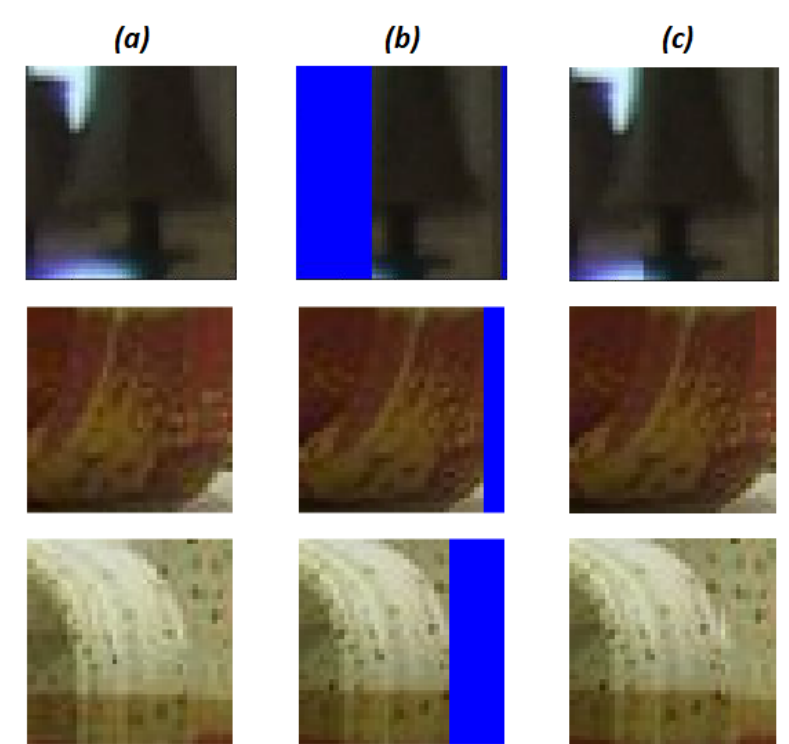
Figure 6. Examples of block composition performed to overcome with partial matching blocks. Each row shows an example of block composition, the first row shows the block number 111 ( a ) of the image “Flowers 1”, the partial matching block ( b ) and the composed block ( c ). The second and third rows are examples of partial matching of blocks extracted from the image “Cones”, related to the blocks number 17 and 13,